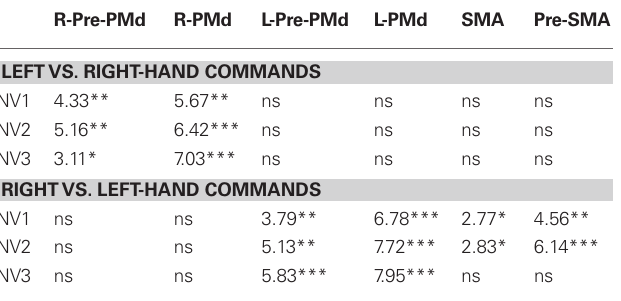
Table A1 | t Values for contrasts left vs. right and right vs. left-hand commands for the rOis in all three normal volunteers.